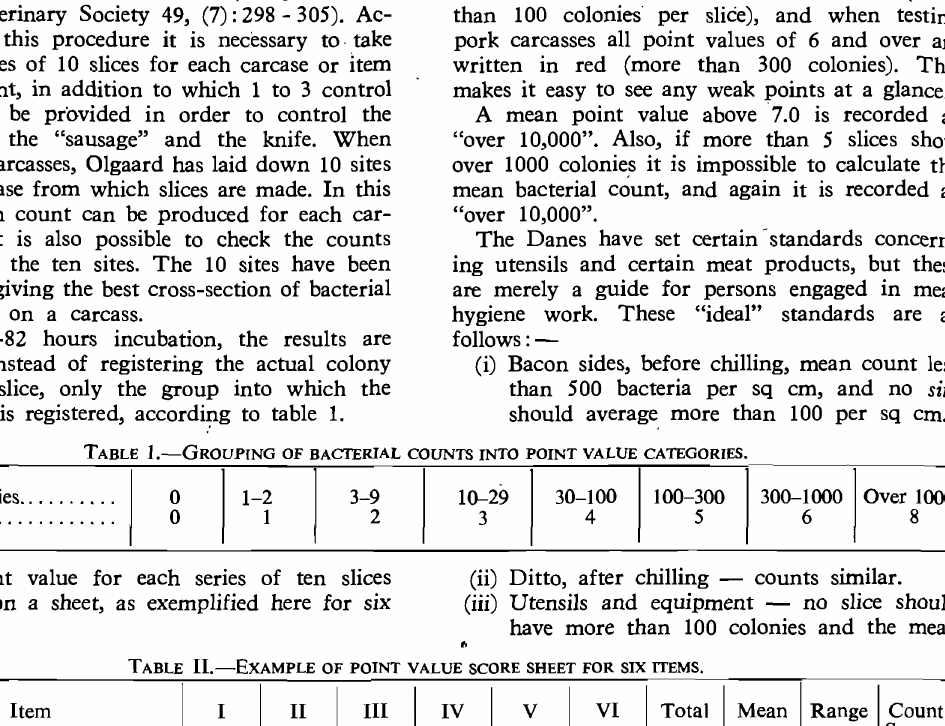
TABLE II -EXAMPLE OF POINT VALUE SCORE SHEET FOR SIX